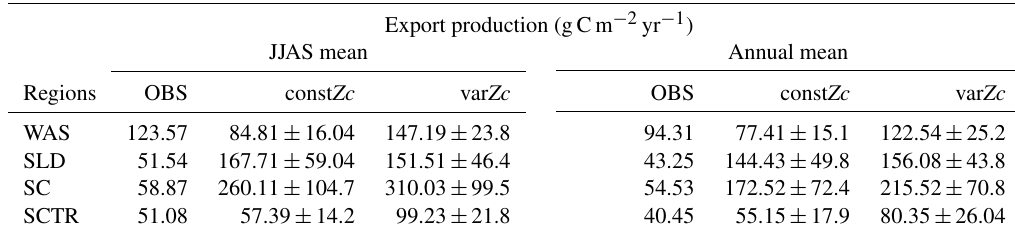
Table 3. JJAS mean and the climatological annual mean of export production from satellite-derived net primary production data, const Zc and var Zc simulations. Units are gCm − 2 yr − 1